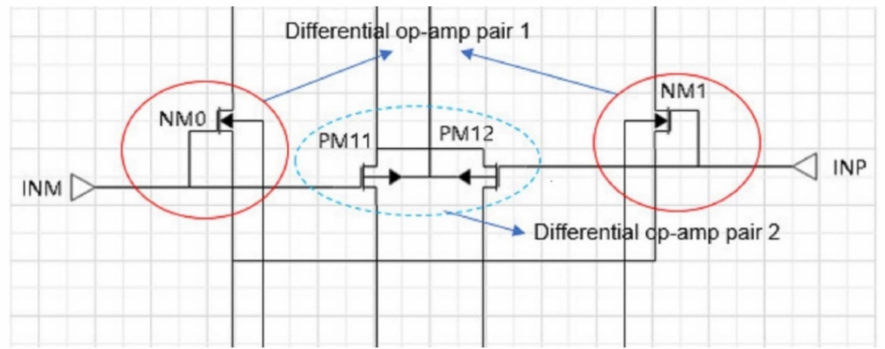
Figure 9. Differential